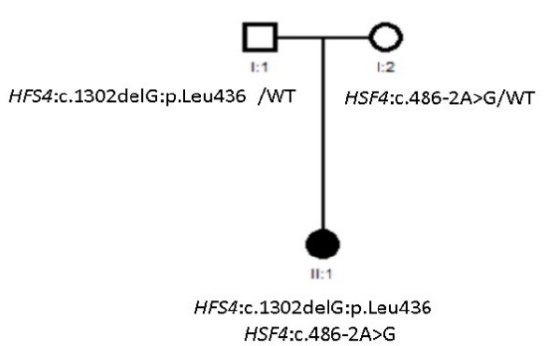
Figure 3. Pedigree of Family 27.